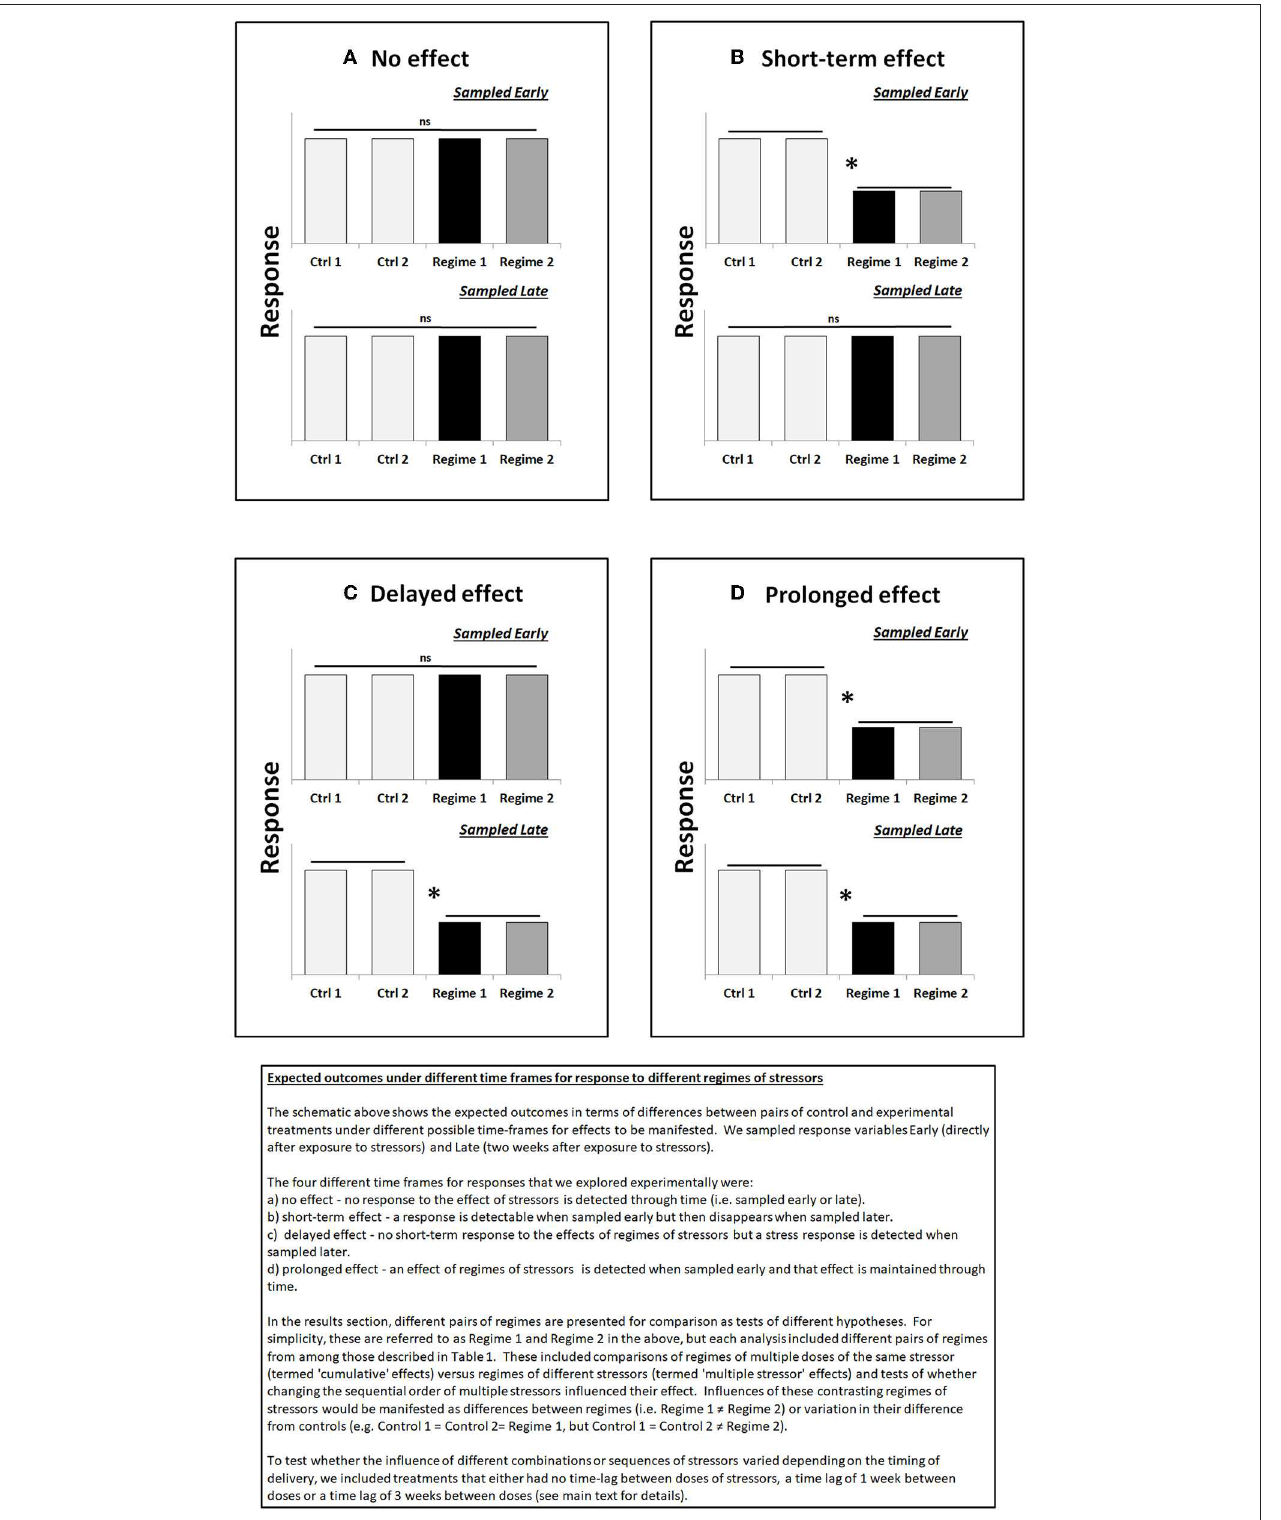
FIGURE 1 | Overview of expected outcomes in time frames for response to different regimes of stressors tested experimentally during the study. (A) No effect. (B) Short-term effect. (C) Delayed effect. (D) Prolonged effect. Asterisks indicate significant differences between individual and/or groups of treatments.